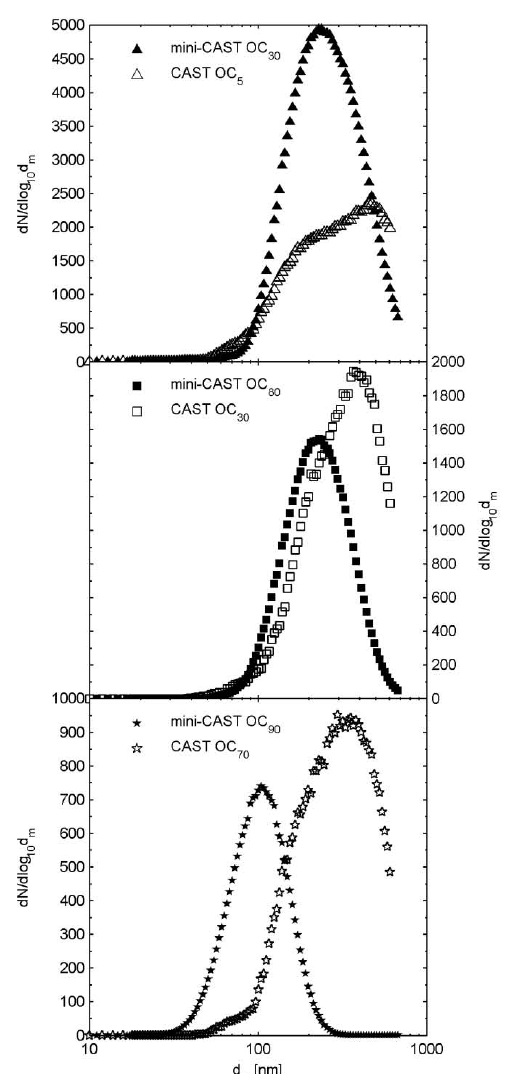
Fig. 4. Comparison of size distributions of mini-CAST and CAST soot as measured with an SMPS; 30%/5% (top), 80%/30% (mid- dle) and 90%/70% (bottom) organic carbon (OC) content after growth in the NAUA aerosol chamber prior to injection into the AIDA aerosol chamber. Note: the coagulation times of the soot in the NAUA chamber before injection into the AIDA chamber were longer for the IN09 case, which explains the difference in modal